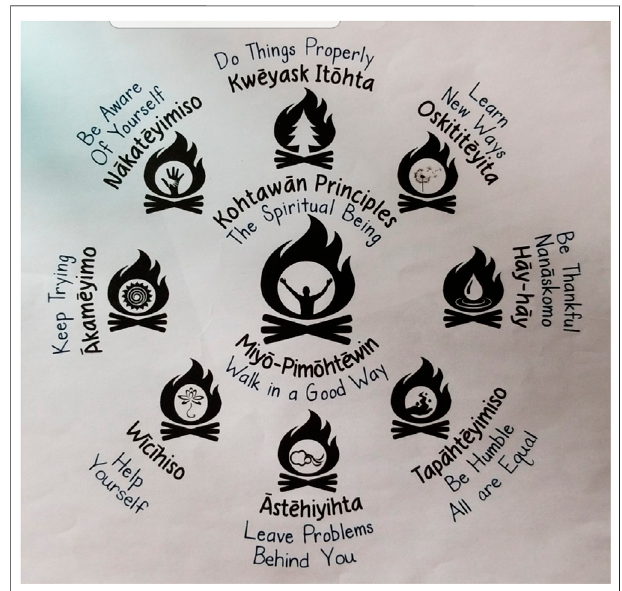
FIGURE 2 | Kohtaw (cid:1) an